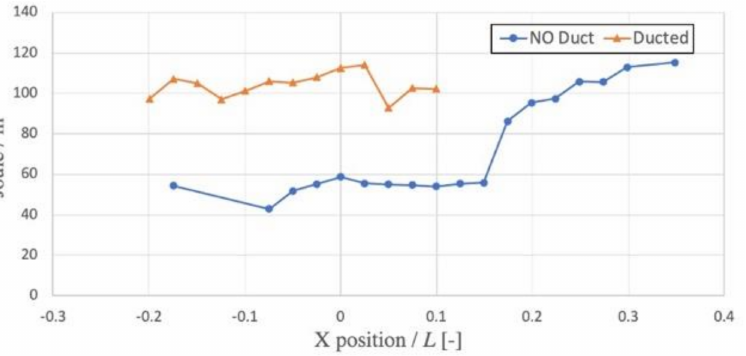
Figure 10. A comparison between the energy (Joule) per m 3 of water of the no duct case (blue circle) and the ducted case (orange triangle) at multiple x / L